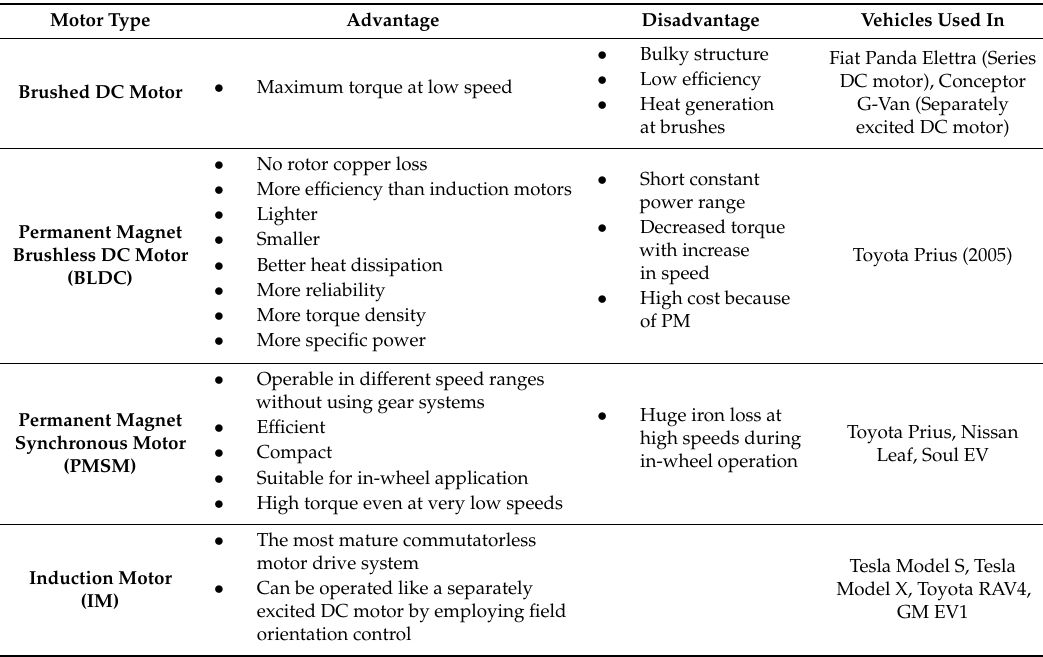
Table 17. Advantages, disadvantages and usage of different motor